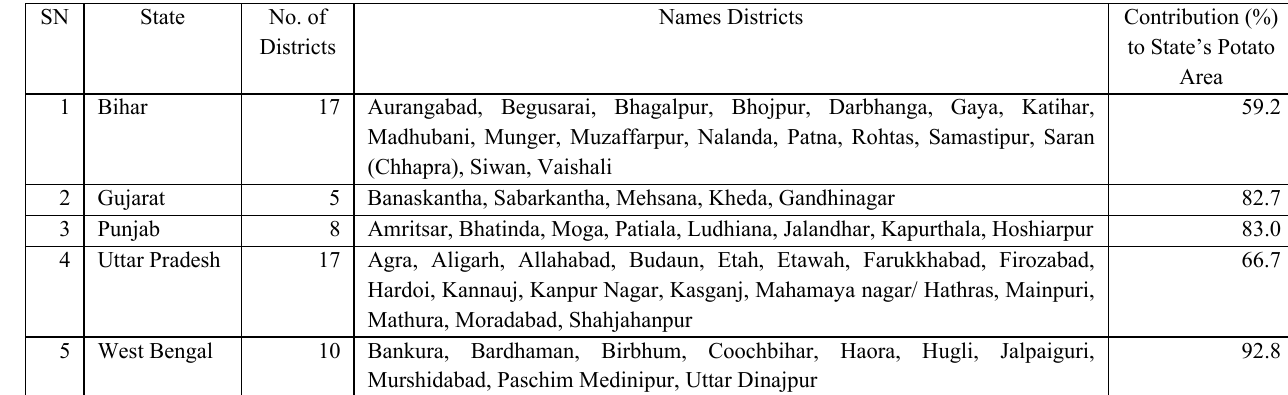
Figure 1. Potato growing states of India for which area and production estimates are carried out under CHAMAN Project.